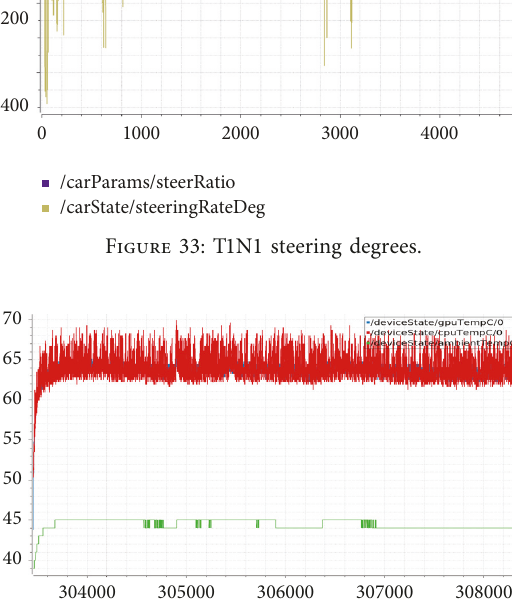
Figure 34: T1N1 steering degrees.